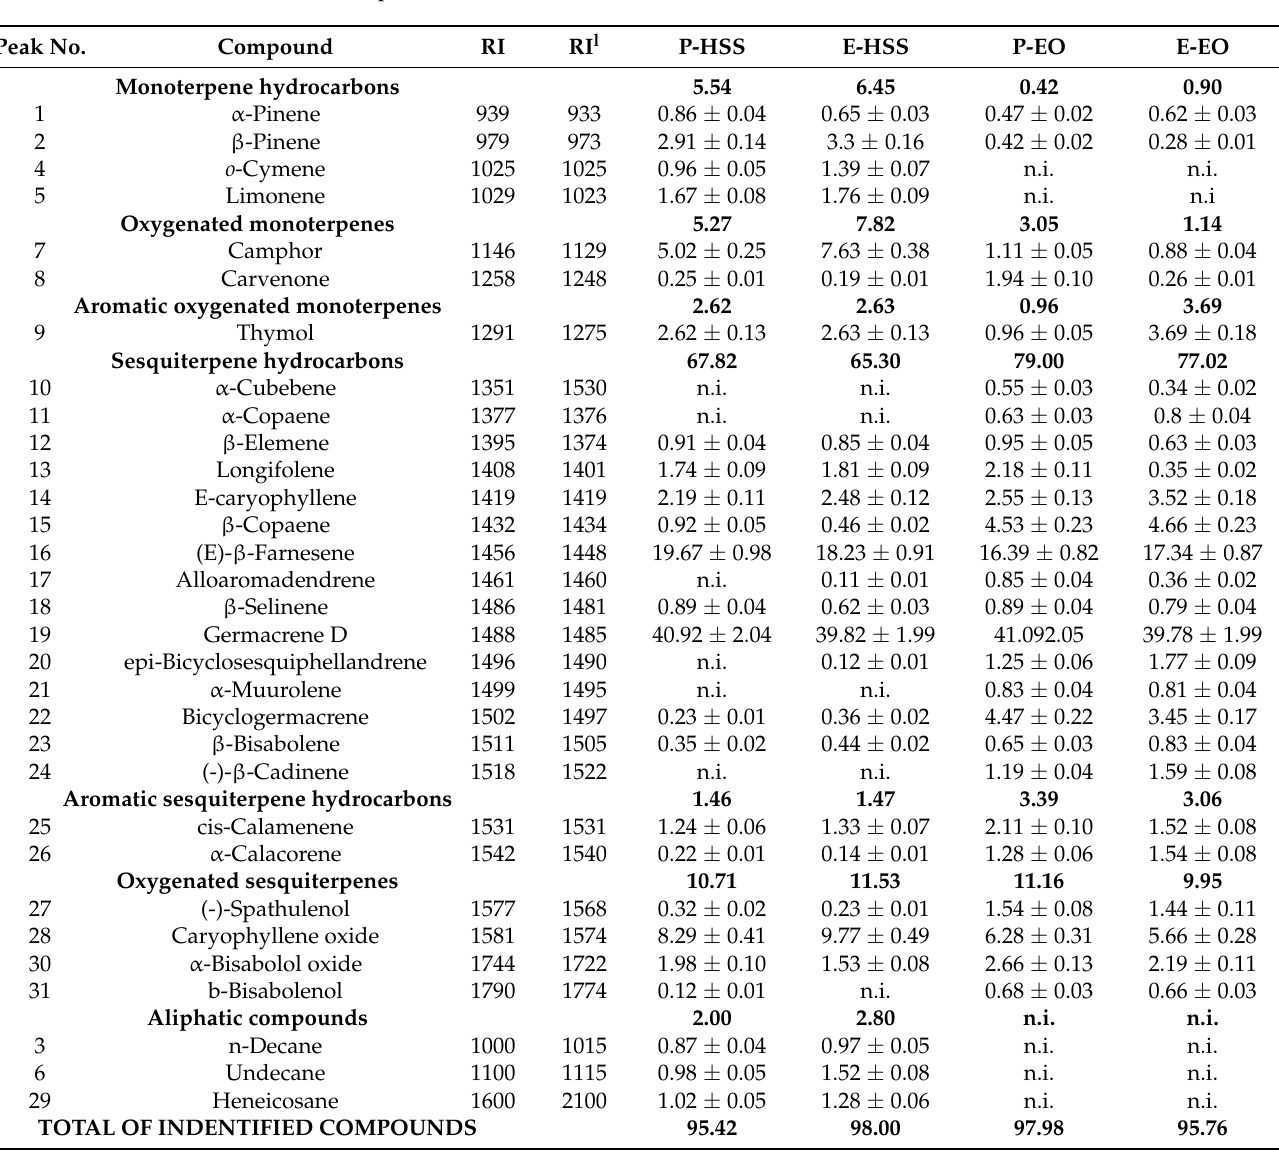
Table 3. The results of volatile organic compounds content analysis in dried leaves and essential oil of Cistus salviifolius (the results are expressed in percentages as mean values ± standard deviation of three